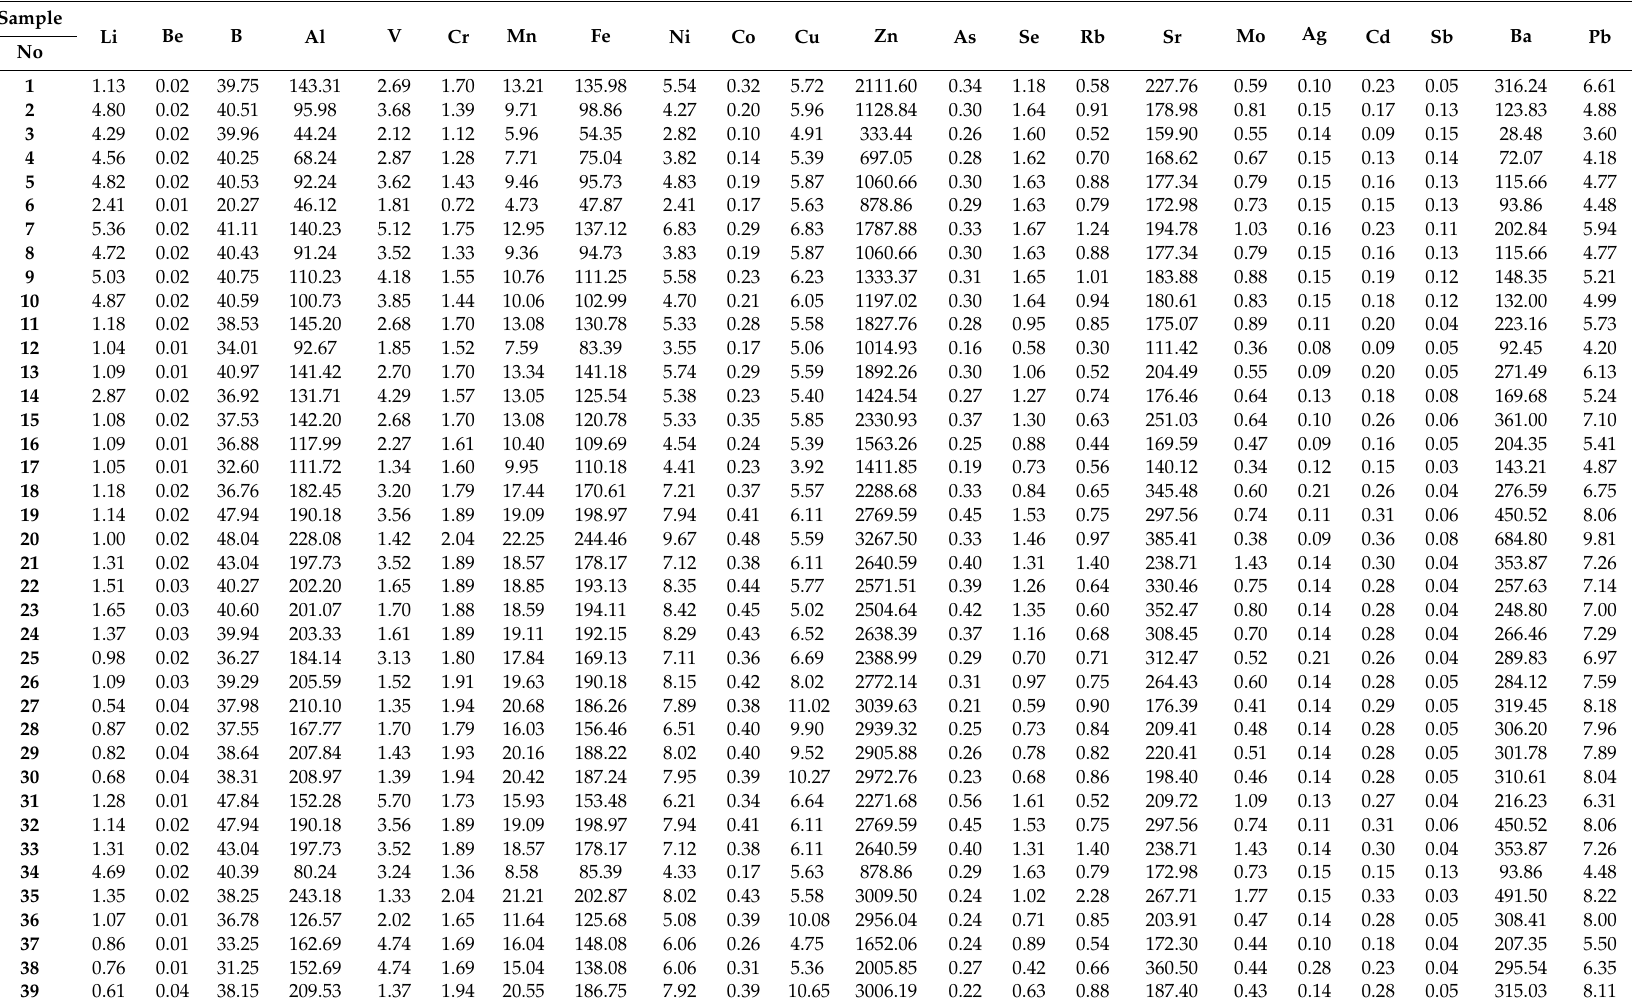
Table 1. Trace metals concentration in groundwater of the study area (All values in